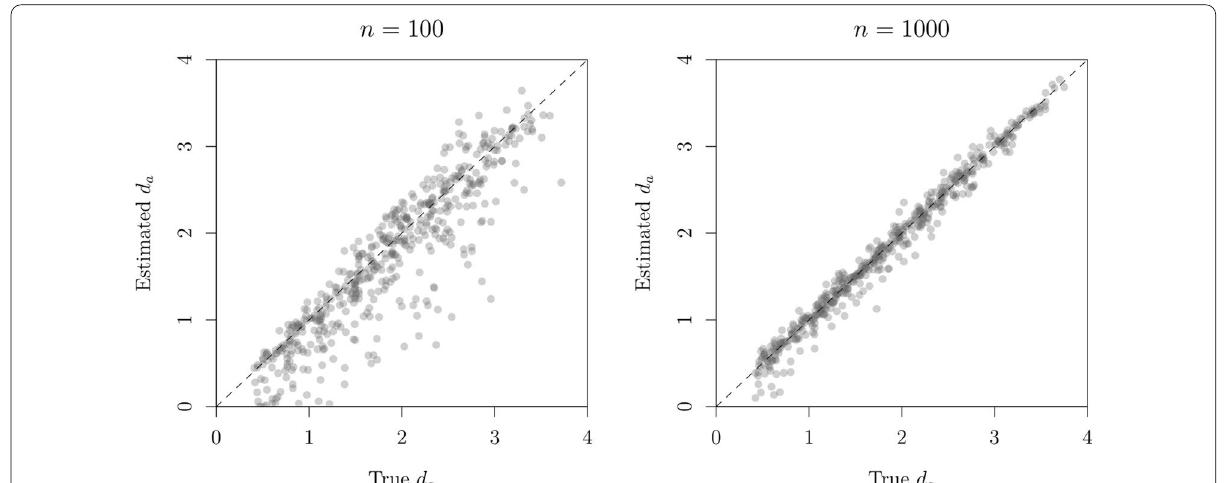
Fig. 11 True and estimated d a from the SDT τ 4, ∅ model, under different n per lineup